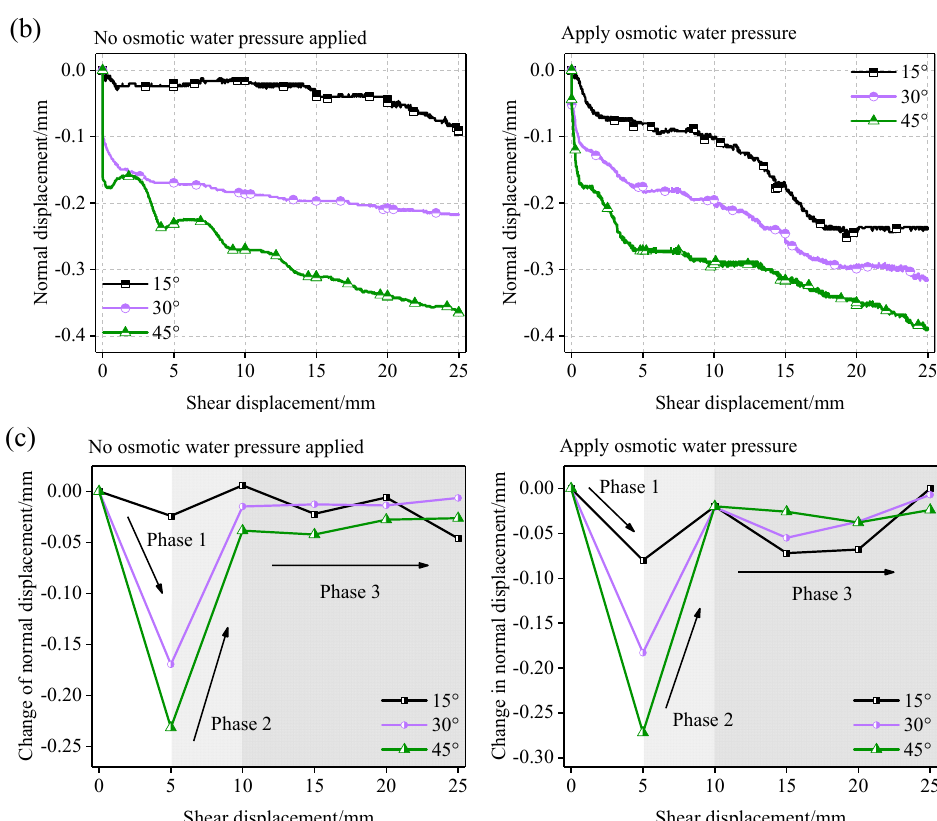
Figure 4. Shear stress–strain curve of a structural plane under the normal stress of 2.25 MPa, showing the ( a ) shear stress shear displacement, ( b ) normal shear displacement, and ( c ) evolution of changes in the normal displacement for successive shear steps.